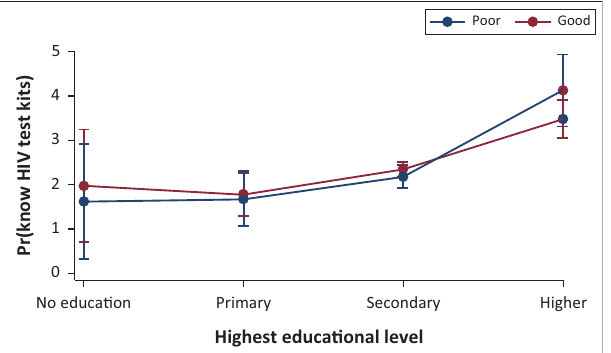
FIGURE 3: Predictive marginal effects of HIV test kits knowledge by residential status and HIV infection knowledge.